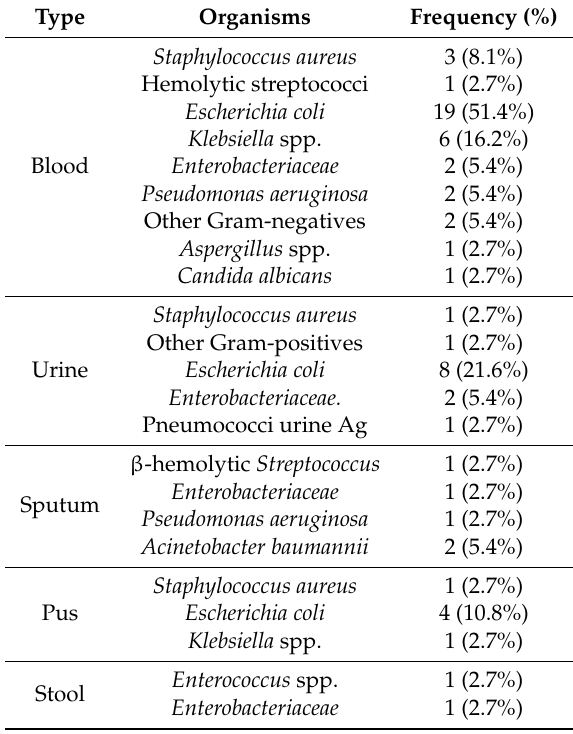
Table 3. Frequencies of Infectious Organisms in the Same Organism Group ( n = 69).